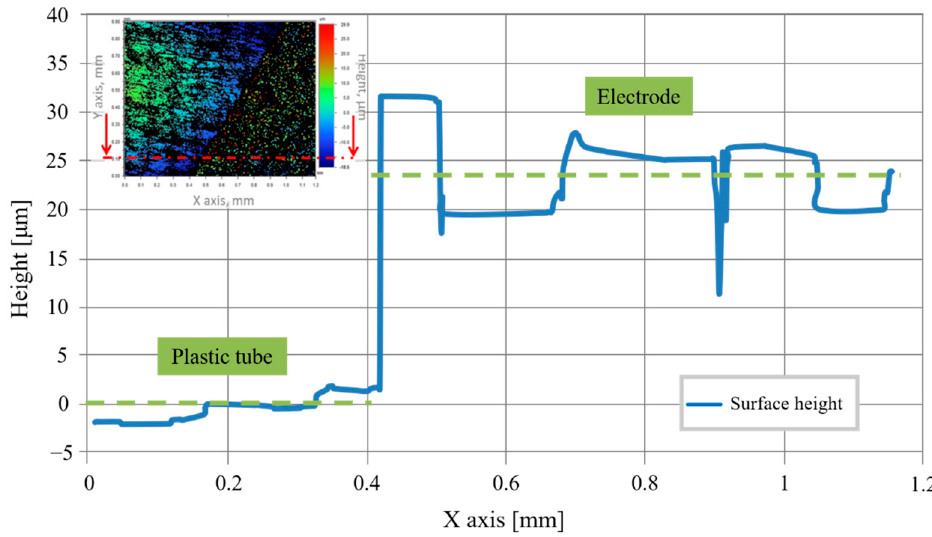
Figure 27. Thickness measurement.